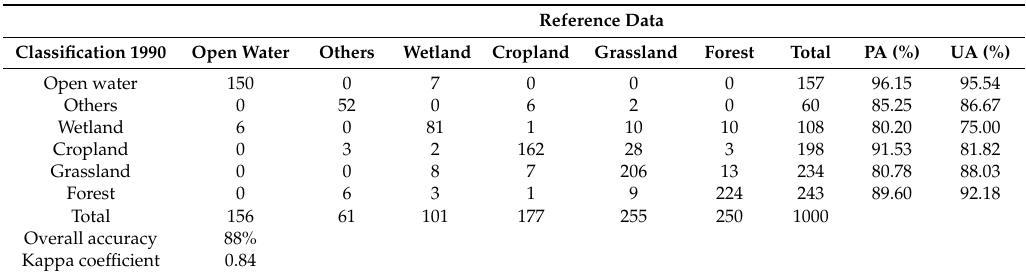
Table 1. Confusion matrix for ca. 1990 with overall accuracy, producer’s accuracy (PA), and user’s accuracy (UA).